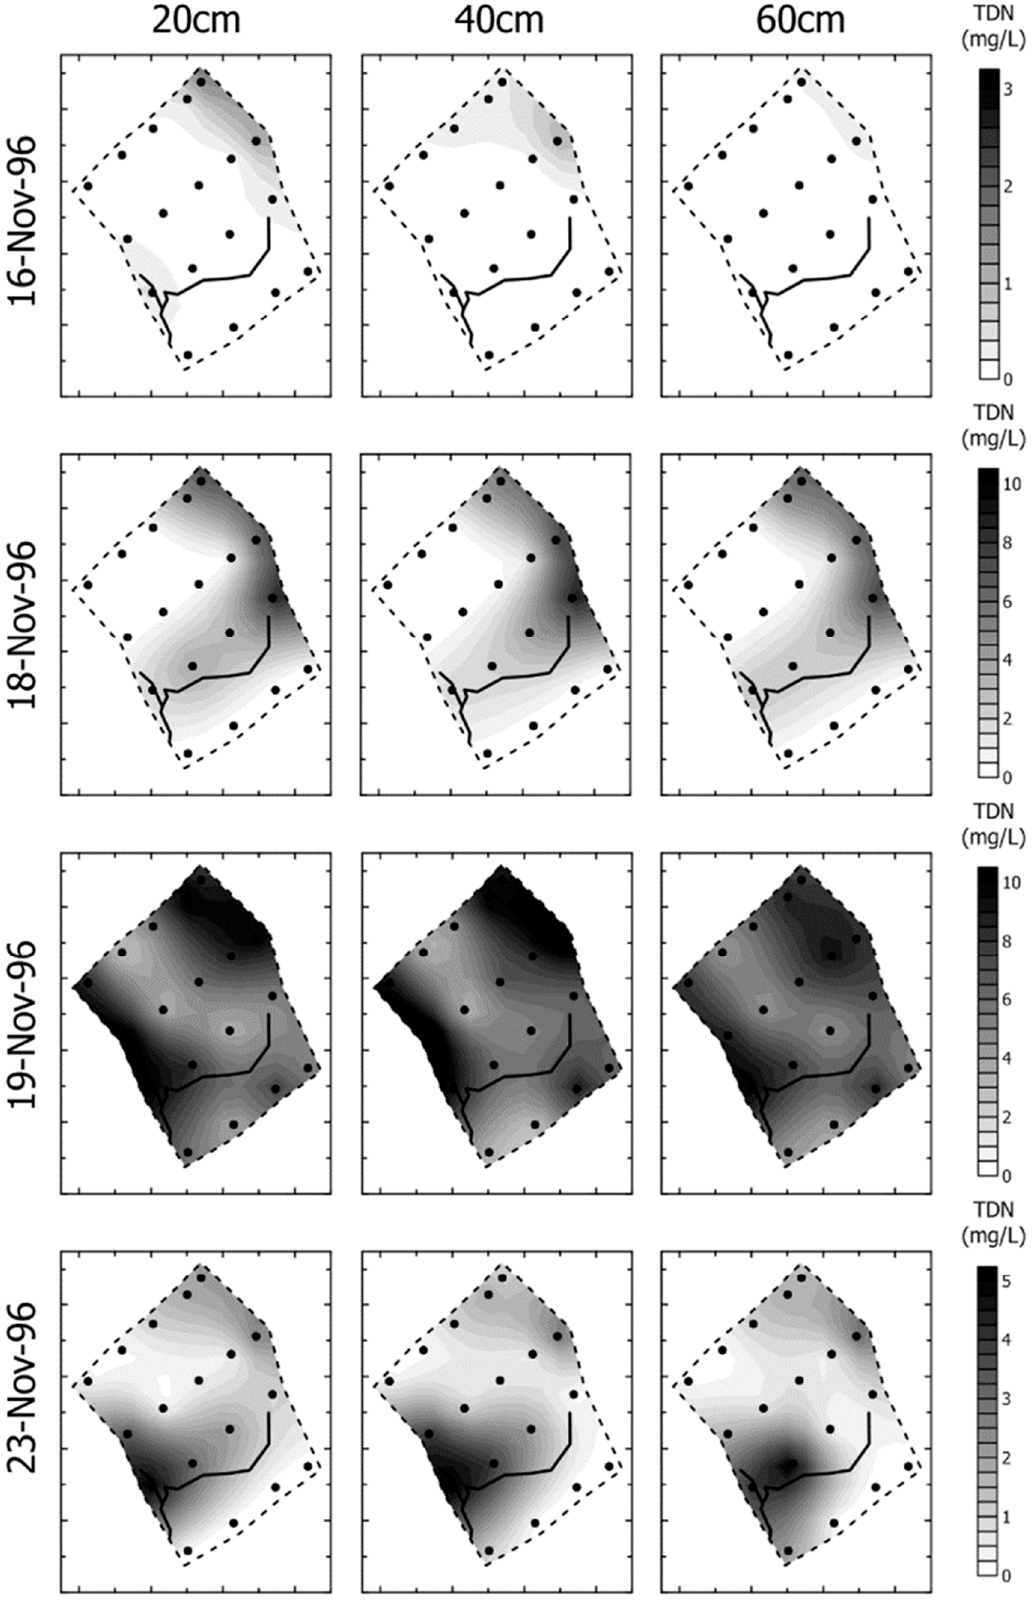
Figure 13. Total dissolved N (TDN) dynamics under storm conditions, 16 November 1996 to 23 November 1996. Note that the scale varies over the course of the event.